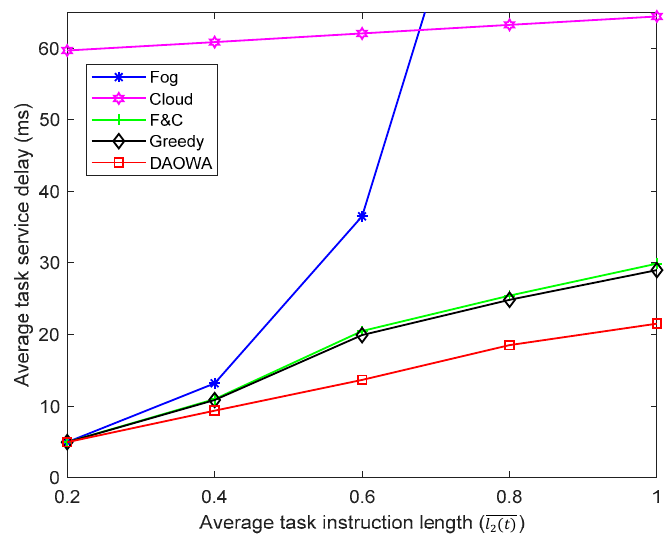
Figure 6. Average task service delay vs. task instruction Figure 6 . Average task service delay vs. task instruction length